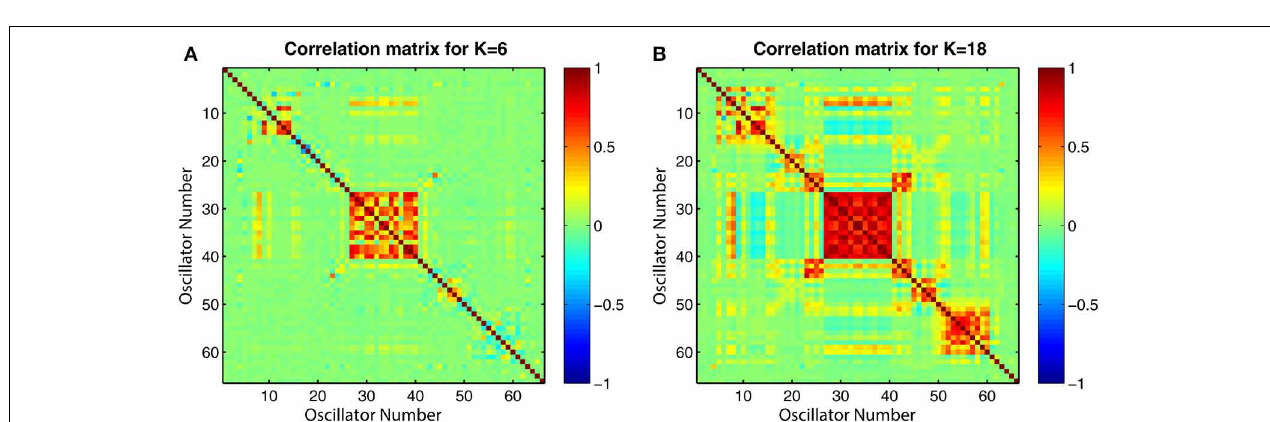
of pairwise distances L between the brain regions that are represented by the 66 oscillators. Matrix L is symmetric, however, matrix C is not because the connection weights are normalized by row. The values associated with the colors of the plots are defined by the color bars. Red colors in (A) represent higher weights. Red colors in (B) represent longer distance connections.